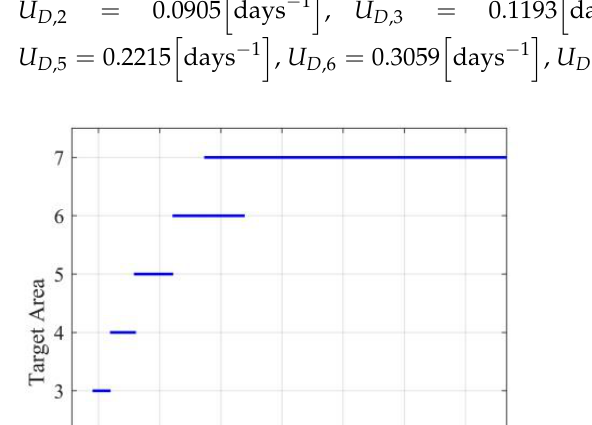
organism concentration response and estimation for single step transition.